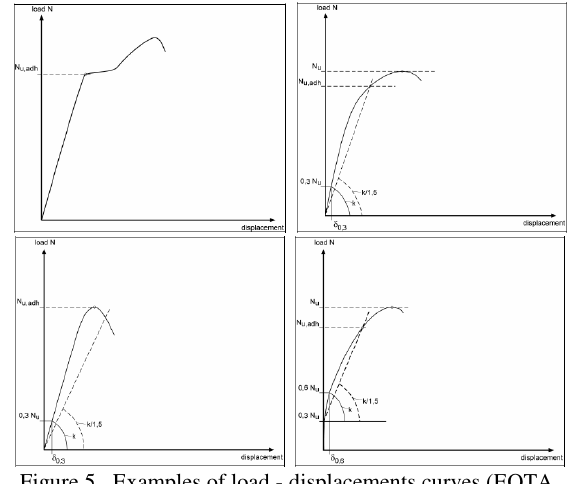
Figure 5. Examples of load - displacements curves (EOTA, 2008)